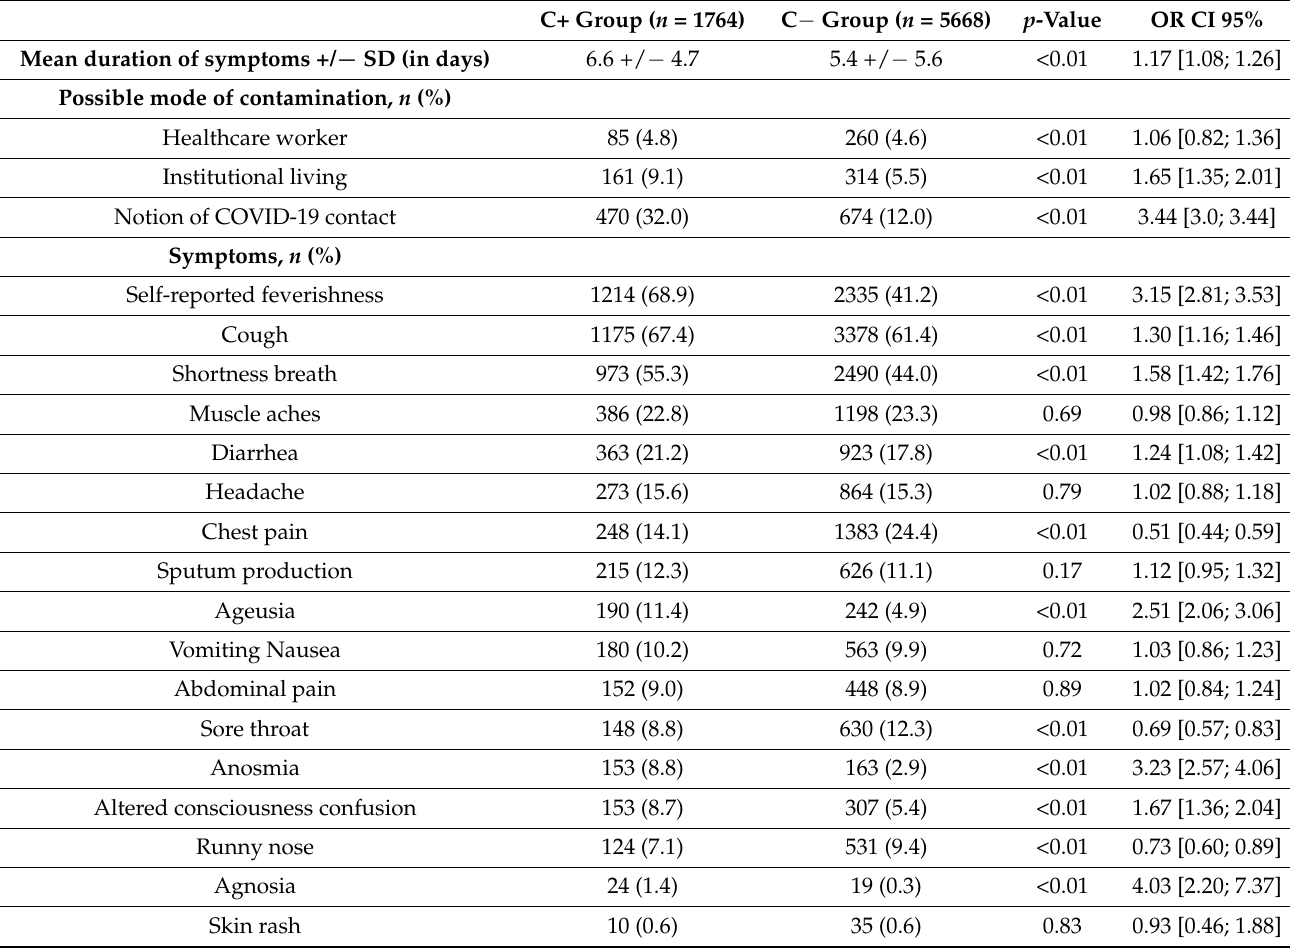
Table 3. Description of COVID-19 symptoms and possible mode of contamination. (Description of missing data by variable in Table